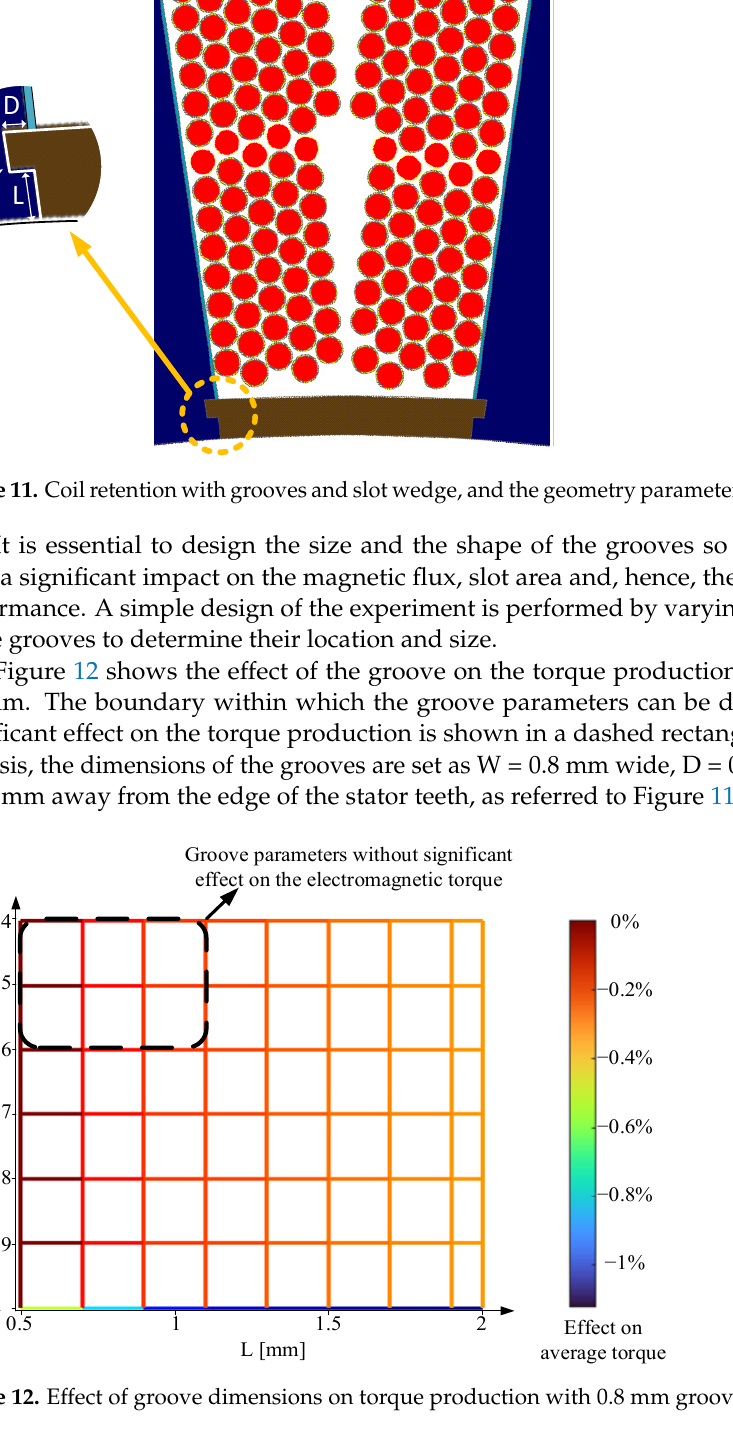
Figure 10. Comparison of AC copper losses for two different coil options.